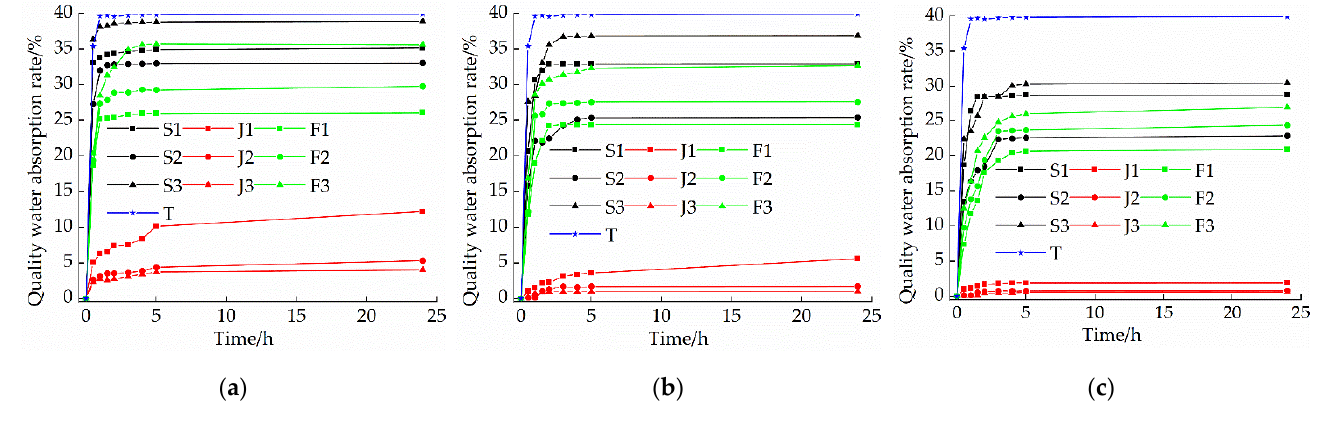
Figure 11. Variation of water absorption rate of sample mass with time under different curing ages: ( a ) Curing 7 d; ( b ) Curing 14 d; ( c ) Curing 28 d .